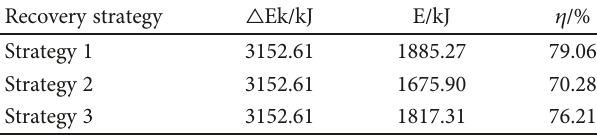
Table 2: Energy recovery under cyclic veri fi cation.